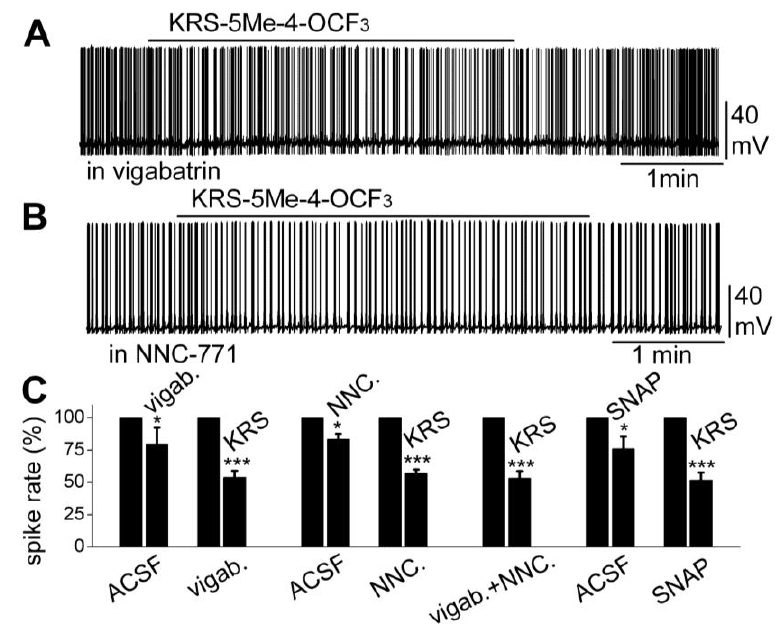
Figure 10. Neither an inhibitor of GABA reuptake nor an inhibitor of GABA degradation enzyme GABA-T blocked the KRS-5Me-4-OCF 3 -evoked mitral cell inhibition. ( A ) Original recording from a mitral cell showing that spiking inhibition evoked by KRS-5Me-4-OCF 3 persisted in the presence of vigabatrin (200 µM). ( B ) Original recording from a mitral cell showing that spiking inhibition evoked by KRS-5Me-4-OCF 3 persisted in the presence of NNC-711 (10 µM). ( C ) Summary of results from normalized and averaged data (* p < 0.05, *** p < 0.001). SNAP (20 μM). From